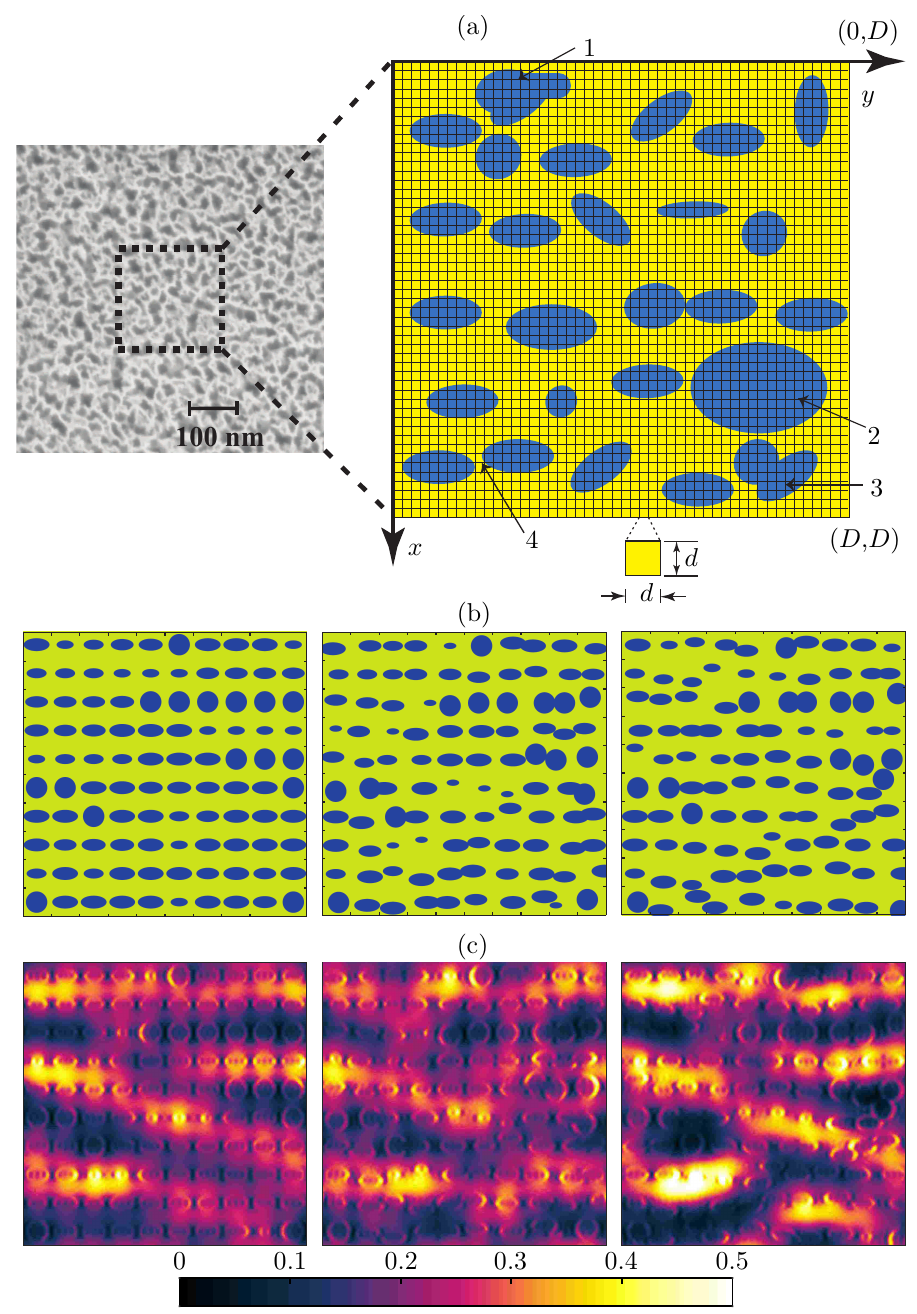
Figure 2. Modeling a porous silicon layer with rigorous grating theory—( a ) ( Left ): scanning electron micrograph showing a top-view of the porous-silicon layer, ( Right ): an illustration of the numerical building block (unit-cell) of the porous silicon monolayer. As illustrated, the unit-cell of size D